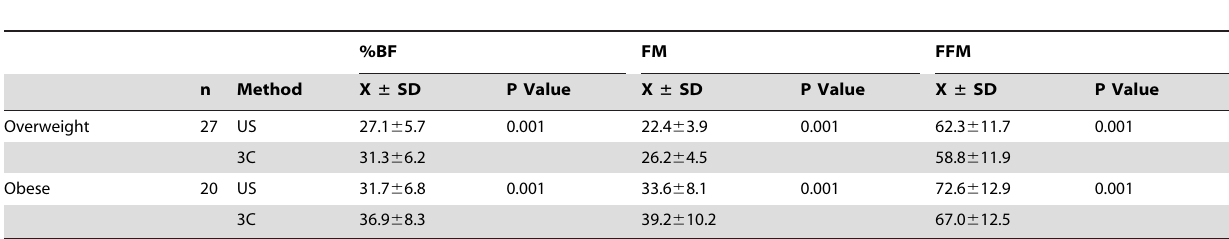
Table 3. Comparison of percent body fat (%BF), fat mass (FM) and fat free mass (FFM) between the ultrasound (US) and 3- compartment model (3C) for overweight and obese subjects. (Mean 6